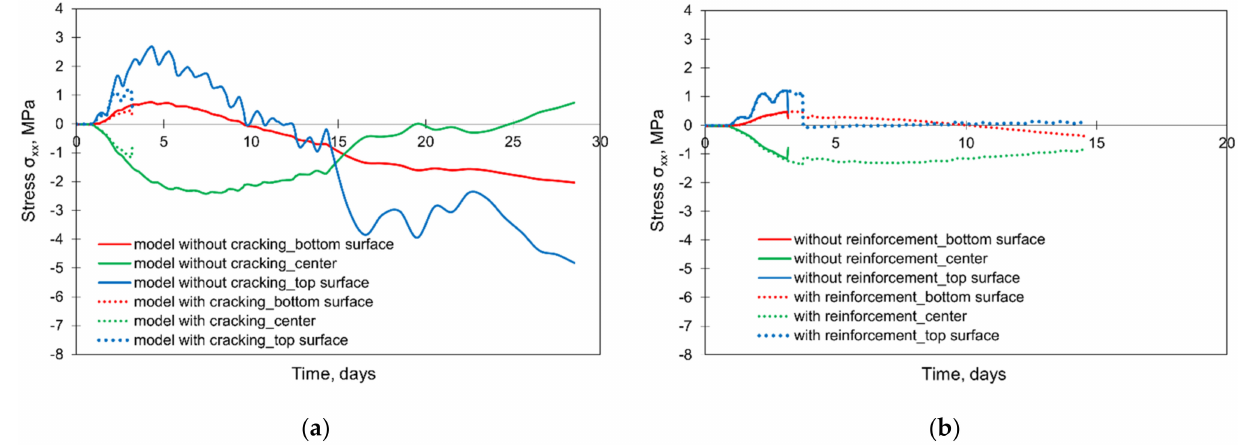
Figure 23. The effect of material model and reinforcement on the development of stress σ xx in the slab with the thickness of 4 m: ( a ) comparison of material models, ( b ) effect of reinforcement in the crack-based material model.